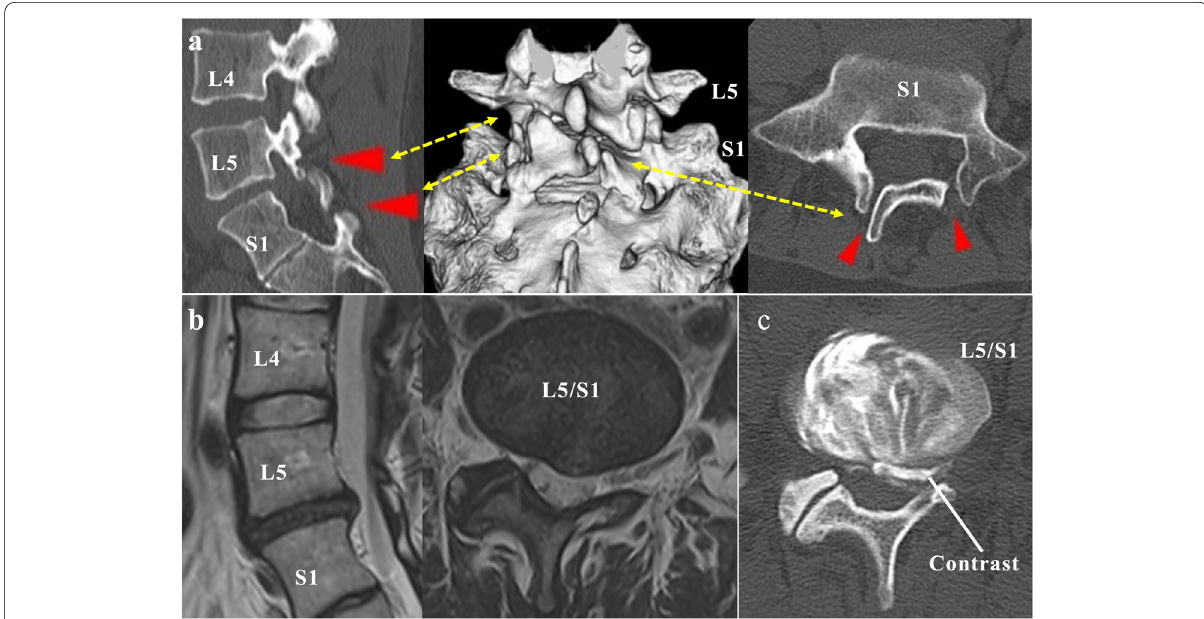
Fig. 2 Preoperative image evaluation. a Sagittal, axial, and reconstructed 3-dimensional computed tomography images show the left L5/S1 abnormal facet complex and unco-ossified S1 lamina (red arrows). b Sagittal and axial T2-weighted magnetic resonance imaging show the L5/S1 degenerative disc compressing the existing left S1 nerve. c Axial computed tomography discography shows the morphologically violated disc at L5/S1. The contrast medium enters the posterior